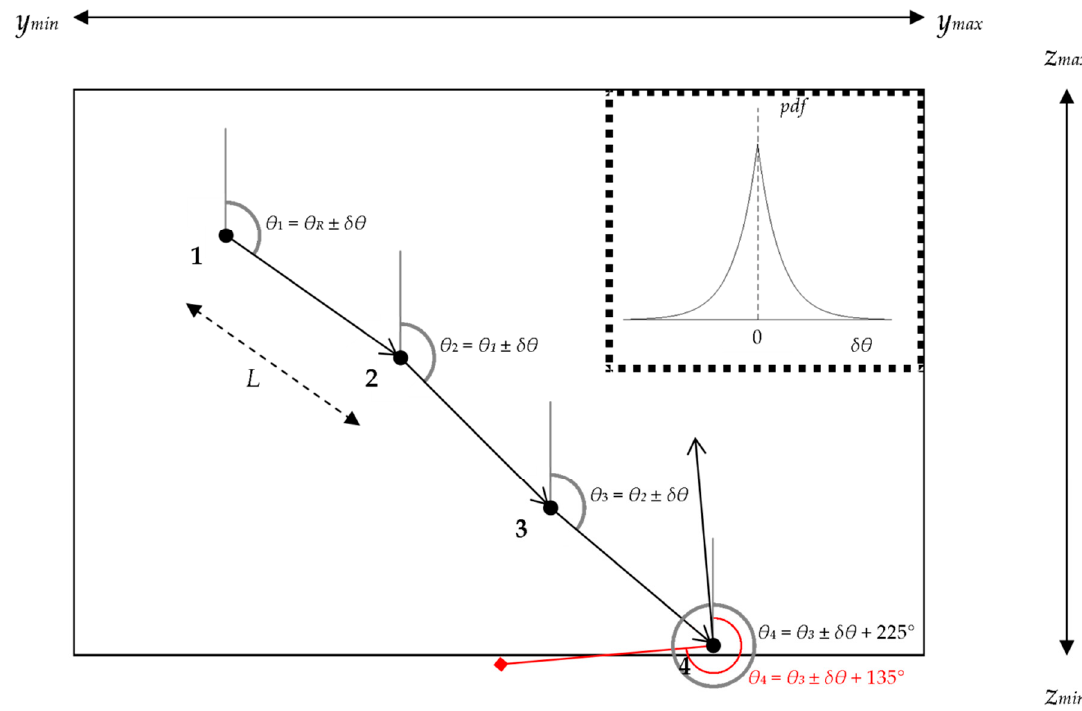
Figure 2. A schematic of the random walk simulation with an example δθ exponential probability distribution function ( pdf ) in the top right hand corner. Each step in the random walk is numbered from 1 to 4. Upon reaching the plane boundary at point 4, a deflection of 225° was applied, since a deflection of 135° (red square) failed to keep the random walk within the confines of spatial sampling. The sampling plane spans from the minimum real y measurement ( y min ) to the maximum real y measurement ( y max ) and from the minimum real z measurement ( z min ) to the maximum real z measurement ( z max ).